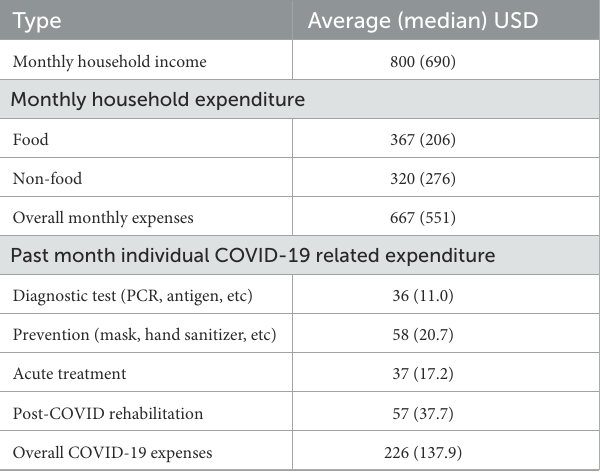
TABLE 2 Monthly income and expenses of the study